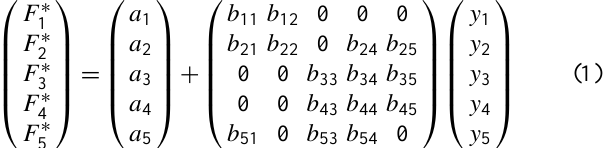
Fig. 1. (a) The domain of the western United States, where the red box denotes the study region over the Sierras. (b) The topography for the study region using the digital elevation model (DEM) at a resolution of 1 km. The scale on the right is in units of meter. The x's represent 80 sub-regions with a resolution of 20 km from which the parameterization data involving 3D radiative transfer was derived (Lee et al. 2011).